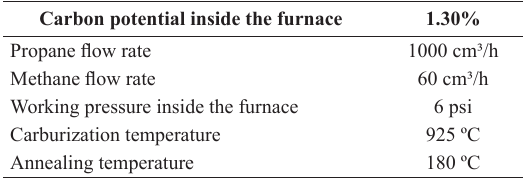
Table 2- Gas Carburization Treatment Parameters.